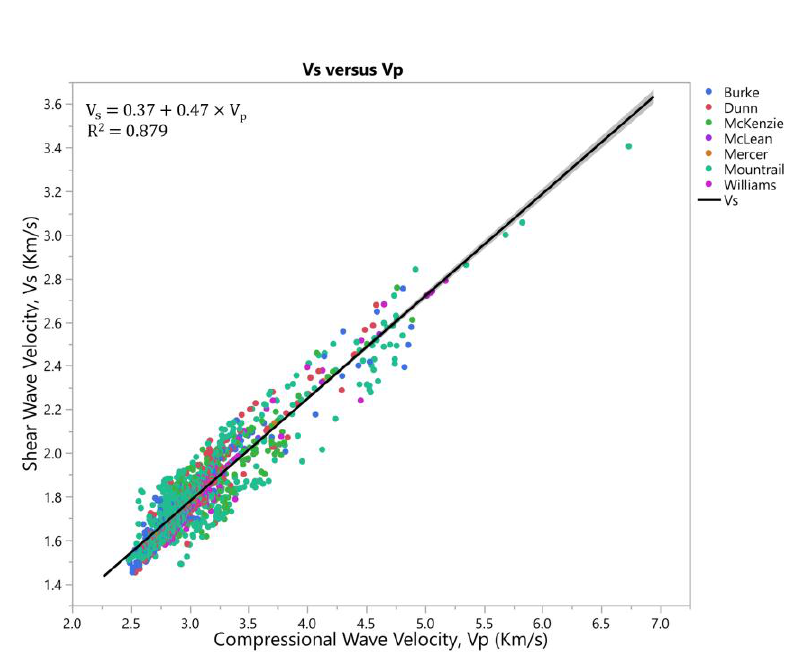
Figure 13. Shear wave velocity versus compressional wave velocity of the Upper Bakken Formation, North Dakota.